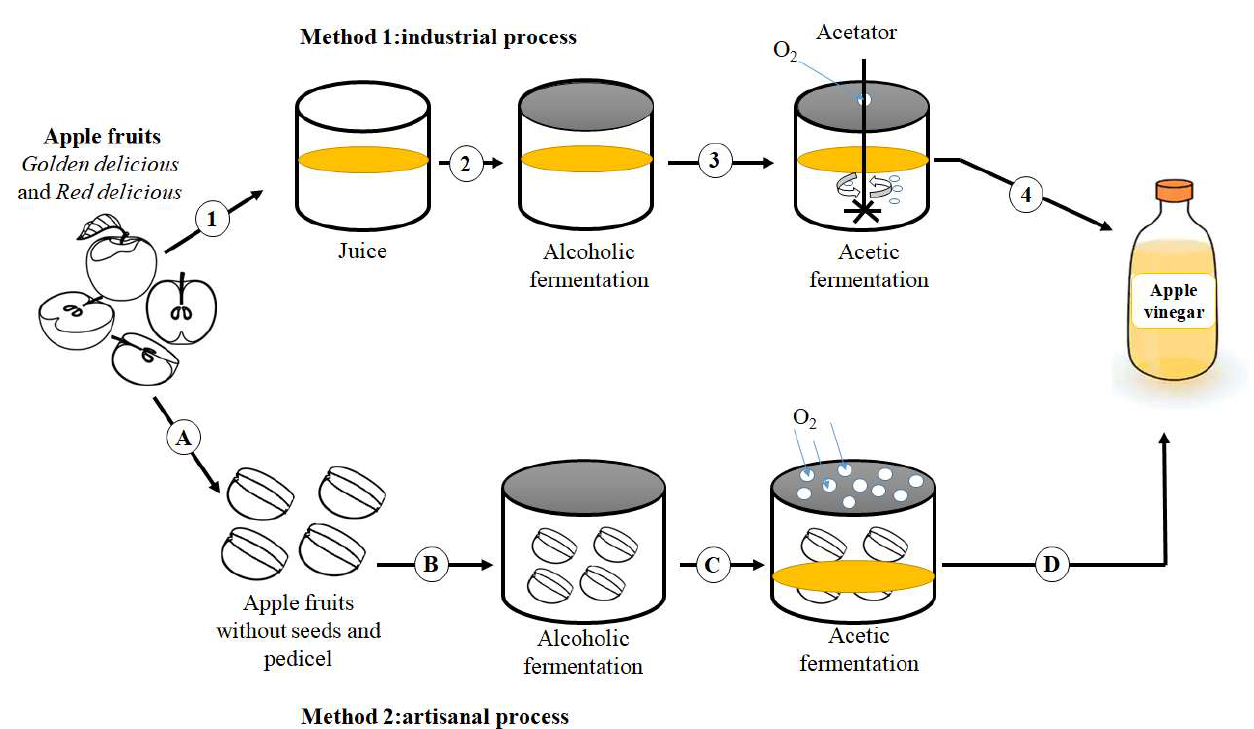
Figure 1. Industrial and artisanal procedures to produce apple vinegar. 1: apple juice extraction; 2: alcoholic fermentation; 3: acetic fermentation; 4: production of vinegar via the industrial method; A: usage of apple fruits without seeds and pedicel; B: alcoholic fermentation; C: acetic fermentation; D: production of vinegar via the artisanal method.